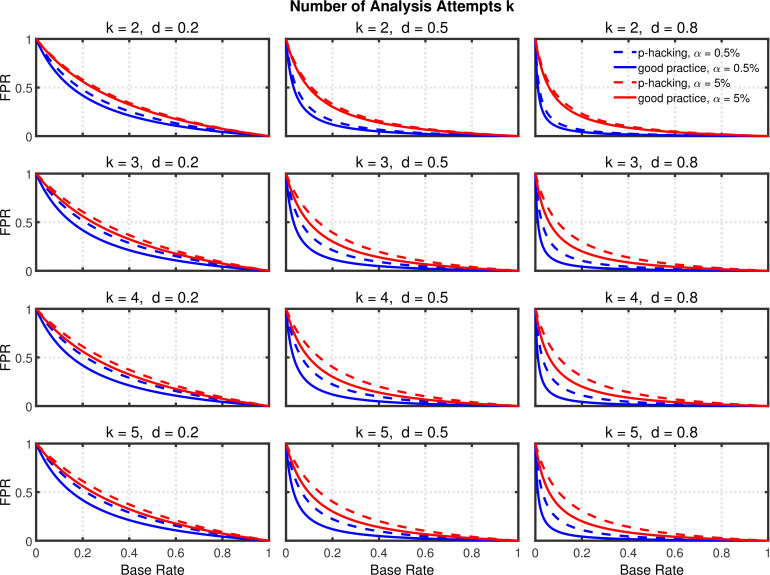
Selective outlier removal.False positive rate (FPR) as a function of the number k of outlier rejection methods attempted, effect size d, and nominal α level (0.5% or 5%). The nominal α level and power of the replication study is α2=0.05 and 1-β2=0.90. Dashed lines give the results for p-hacking whereas solid lines depict the results for researchers who act according to good scientific practice. Simulated data included no outliers.